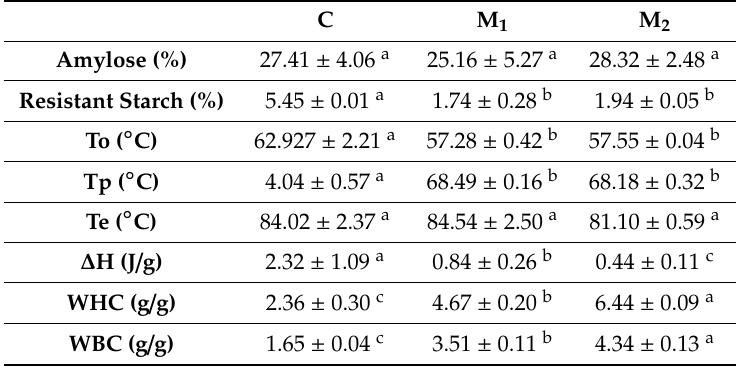
Table 1. Physicochemical properties of three di ff erent corn flours (C, M 1 and M 2